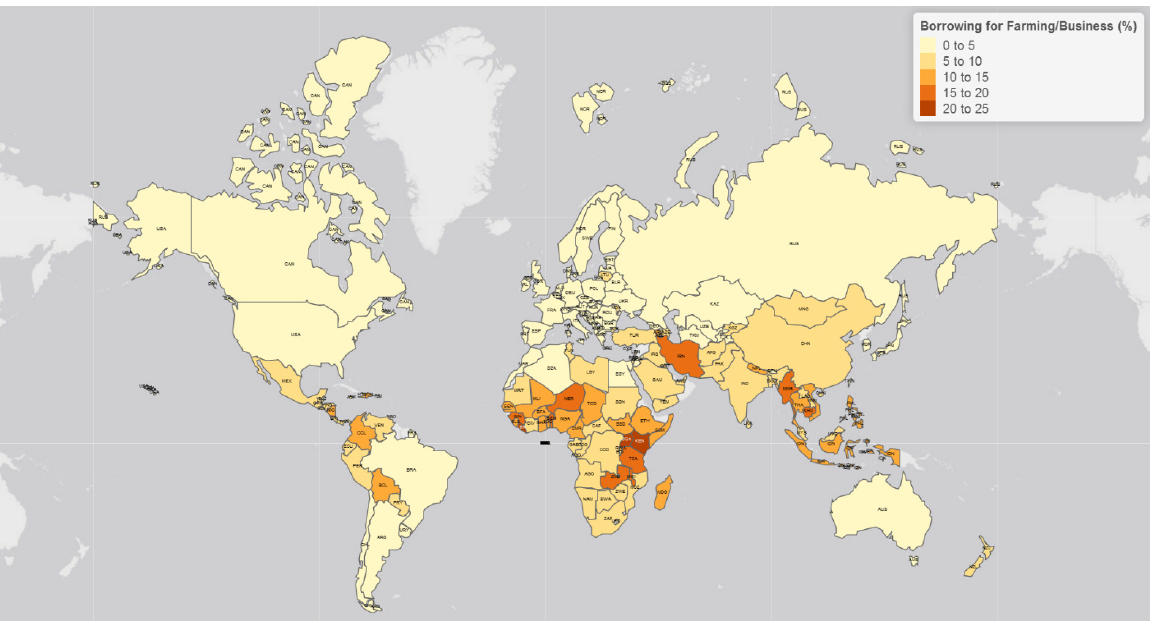
Figure A4. Country level weighted proportion of borrowers for entrepreneurial (farming or business) purposes between 2014 and 2017, globally. Source: Author’s own construction using the global financial inclusion surveys (2014 and 2017). (See dynamic web link at